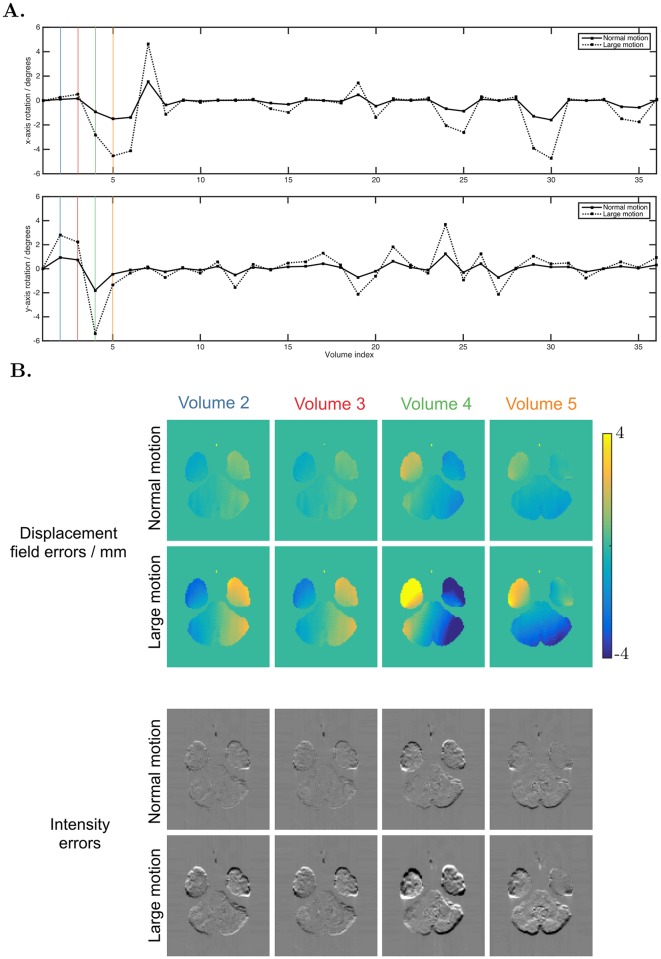
Susceptibility-movement interaction.A. The x- and y- rotation parameters used for the simulation of the first 36 volumes (z-rotations not shown because they do not contribute to the dynamic susceptibility effect, translations were all 0). The coloured vertical lines highlight the motion of the volumes depicted in plot B. B. Top two rows show the errors in displacement field caused by the dynamic portion of the susceptibility artefact, for volumes 2-5 of the acquisition—the motion these volumes experienced is highlighted with colour in plot A. Bottom two rows show the error in intensity of these volumes after they are corrected for motion and the static portion of the susceptibility field, obtained by subtraction from ground truth images.